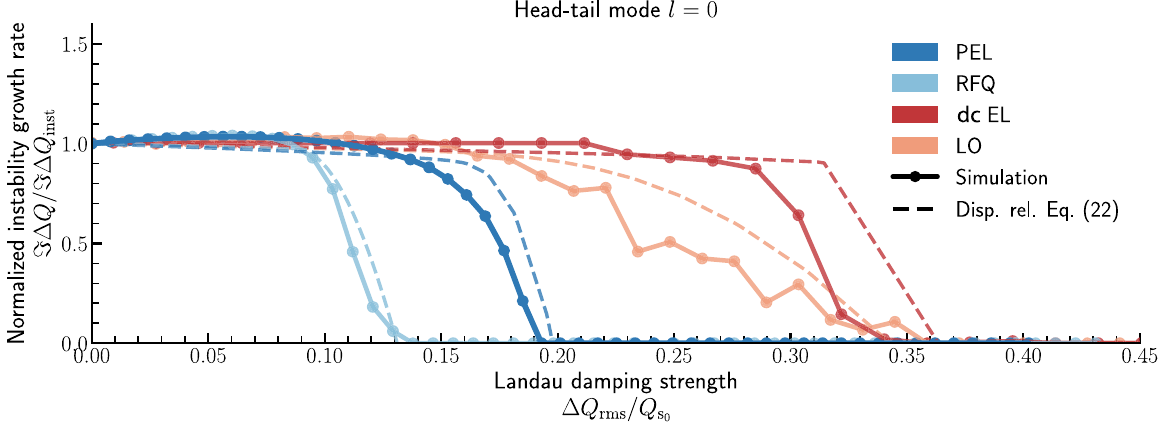
=Q for head-tail mode l ¼ 0 . A PEL (dark-blue), rms s 0